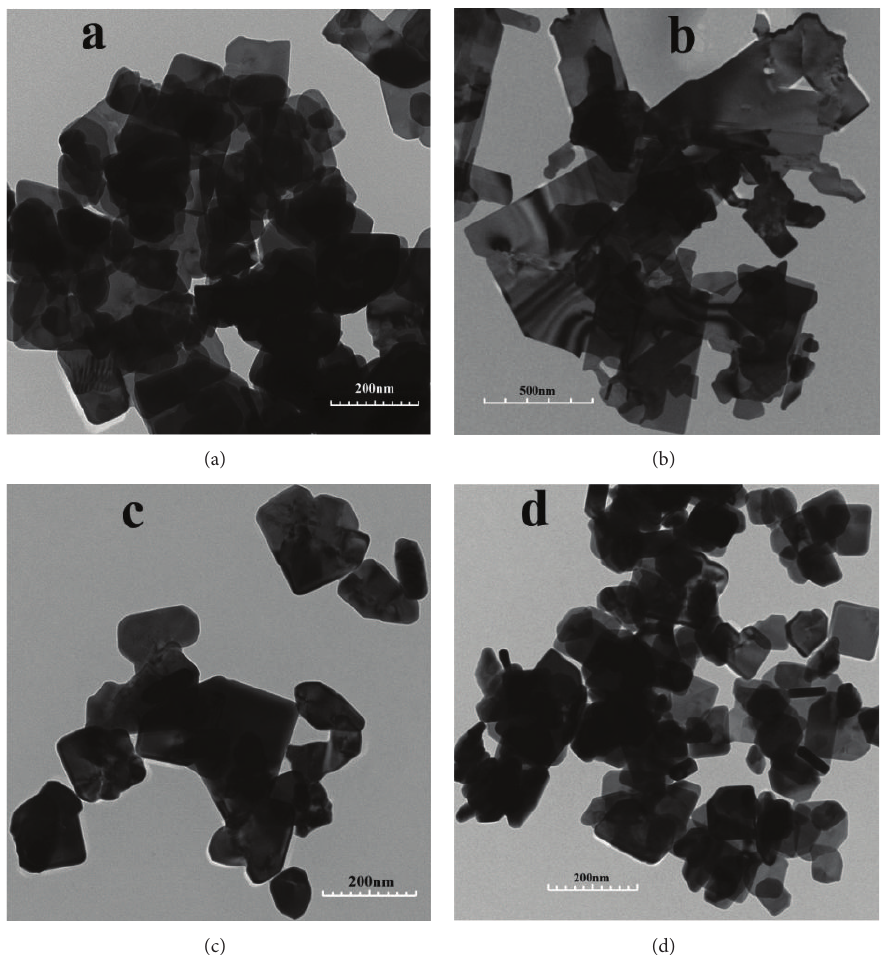
Figure 2: TEM images of the various photocatalysts: (a) S1, (b) S2, (c) S3, and (d) S4,